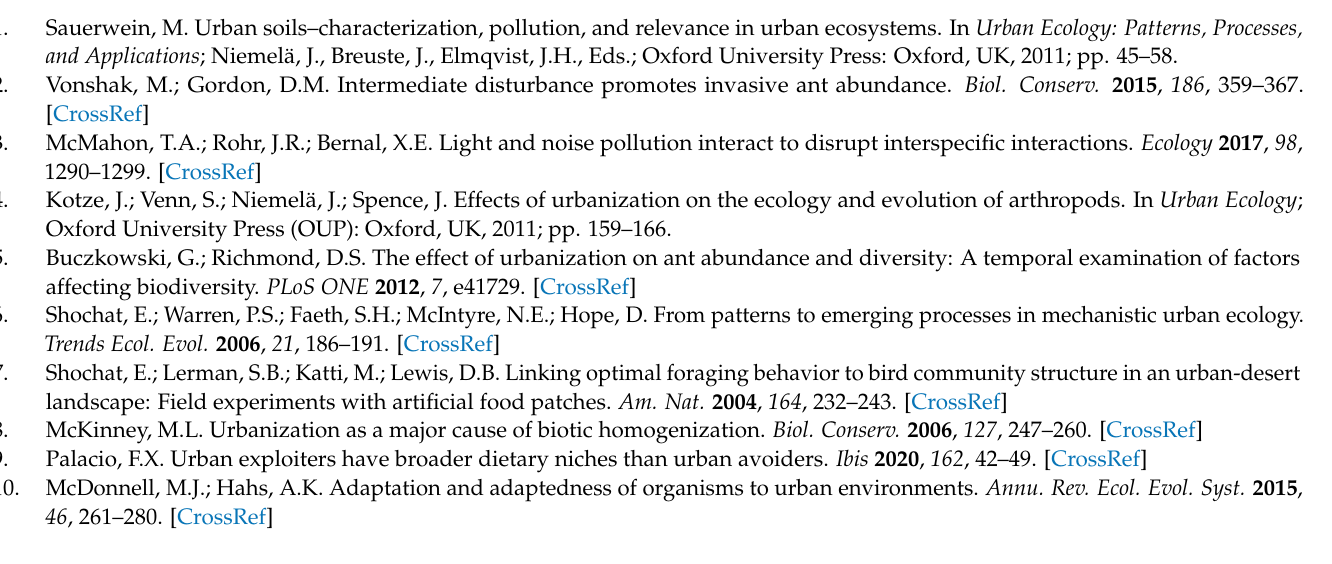
Table S1: Results of the link between the distance from the wall, body mass, soil depth, and pit area in the field and the lab, Table S2: Results of the second measurement of light intensity (late May) and measurements demonstrating a link between illumination and temperature, Excel File S1: The whole